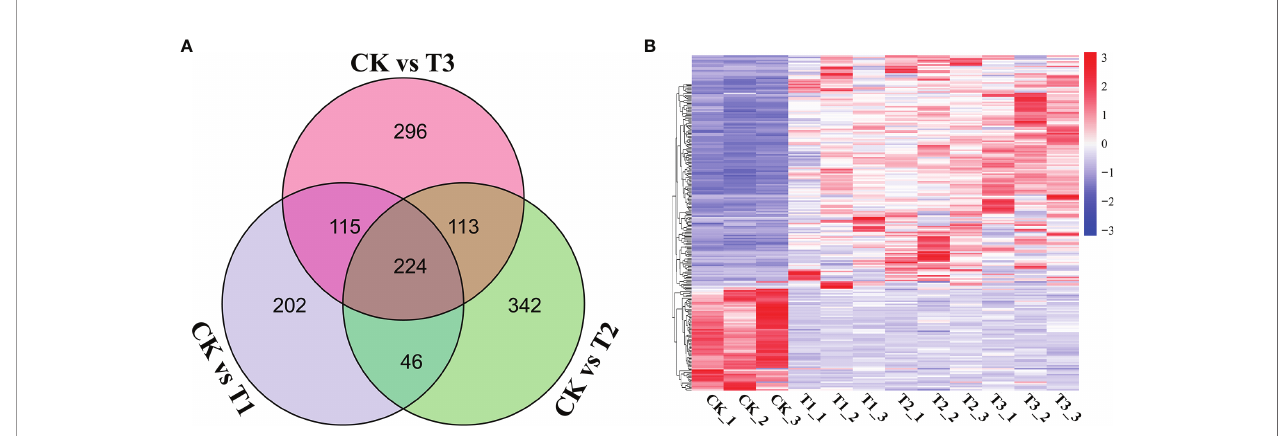
FIGURE 4 | Clustering analysis of DEGs between the three comparisons. (A) The DEGs in the three comparisons are exhibited in a Venn diagram. (B) The heatmap exhibits the variance in the expression of overlapping DEGs on the basis of the fragments per kilobase of transcript per million mapped read (FPKM) values. Genes with contents with greater than the mean are highlighted in red, while those with expression levels below the mean are highlighted in